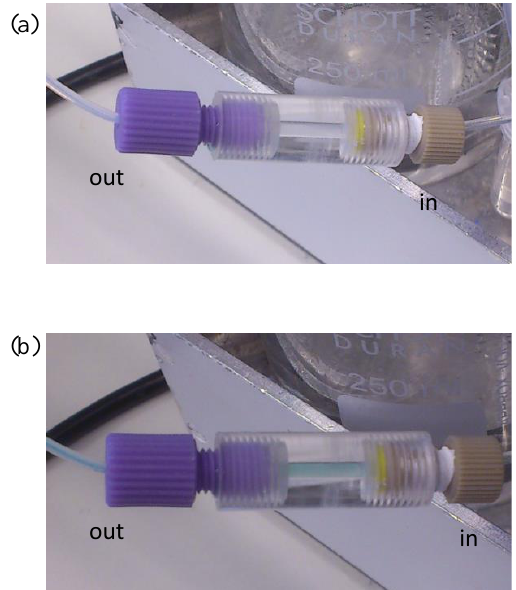
Figure 4. Photographs showing ( a ) clear column before the reaction with substrate and ( b ) blue column during reaction.